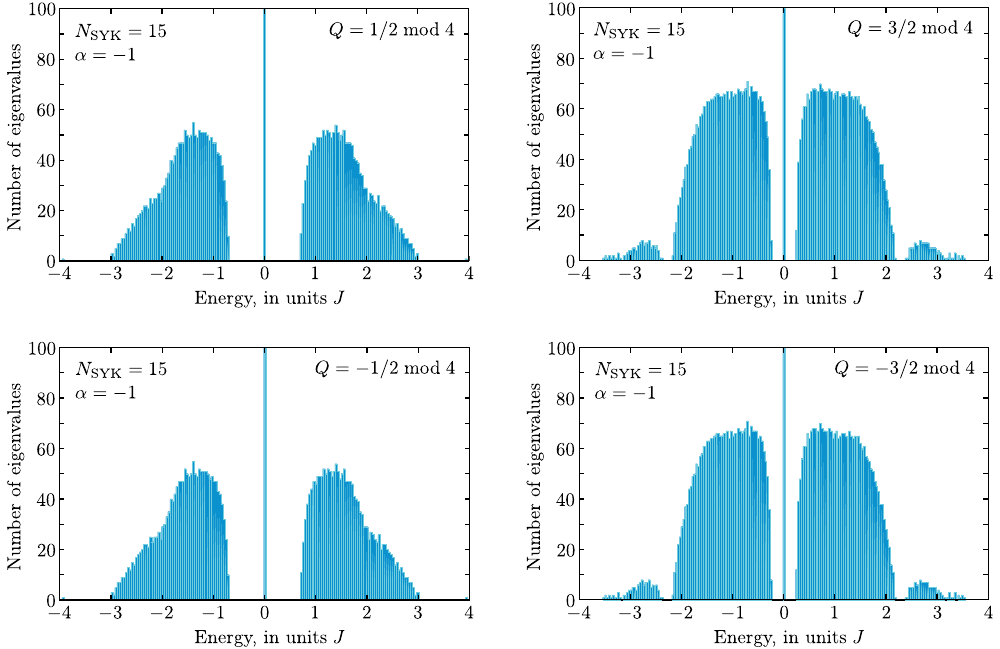
15 and α ¼ − 1 separated into four Z 4 SYK ¼